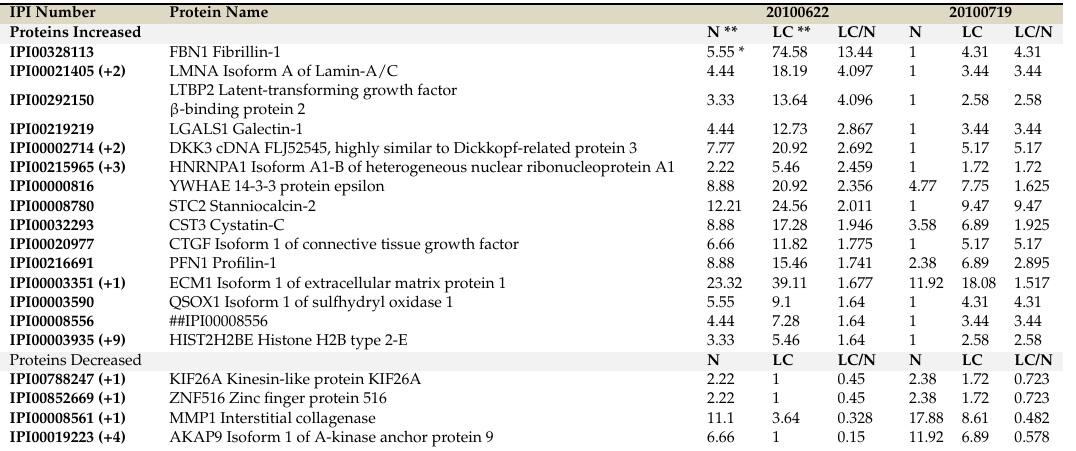
Table 1. Proteins identified by LC–MS/MS analysis with an increase/decrease in lung cancer sample over 1.5-fold change.